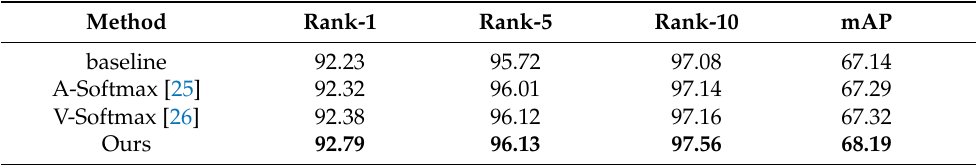
Table 8. Comparison experiments on VeRi.